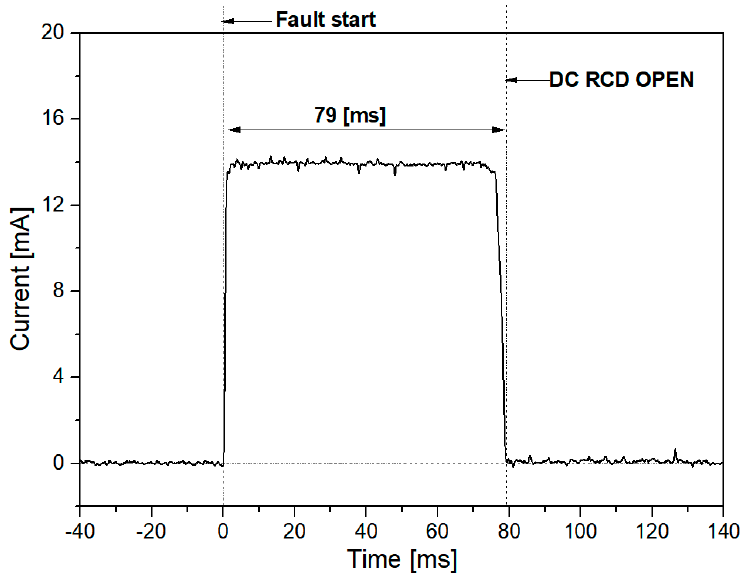
Figure 8. Waveform of the operational test that generated an artificial leakage current of 14 mA for the DC RCD under development.